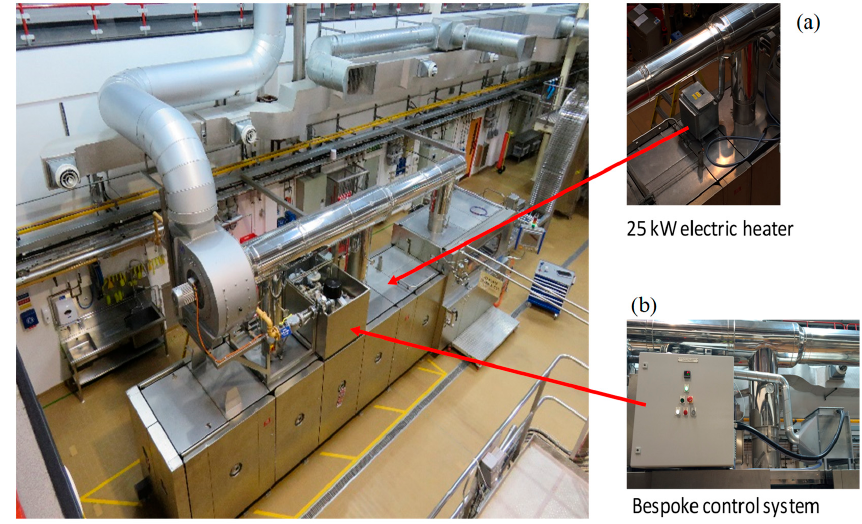
Figure 2. The pilot-scale baking oven with retrofitted bespoke electric resistance duct heater and its control system [38]. Table 1. Design parameters for a combustion air resistance heater.